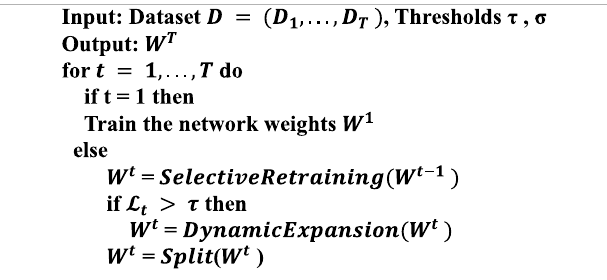
TABLE 2 | The performance exhibited by different models on dataset 1. The speci fi c type of classi fi cation